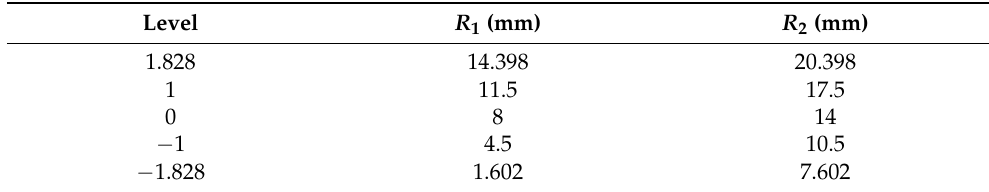
Table 3. Levels of design variables of the fluid domain.